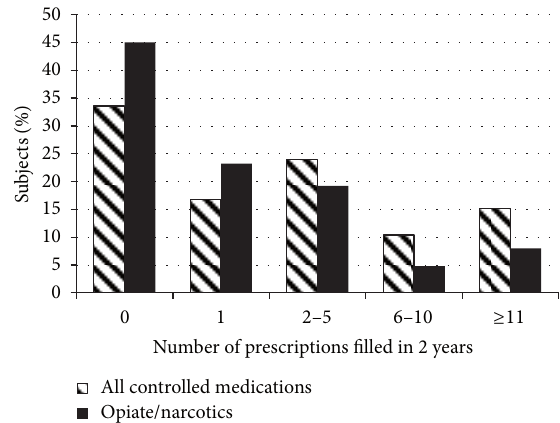
Figure 1: Distribution of total number of prescriptions for all controlled medications and opiate/narcotics filled in the 2 years prior to presentation for outpatient medication-assisted treatment for opioid